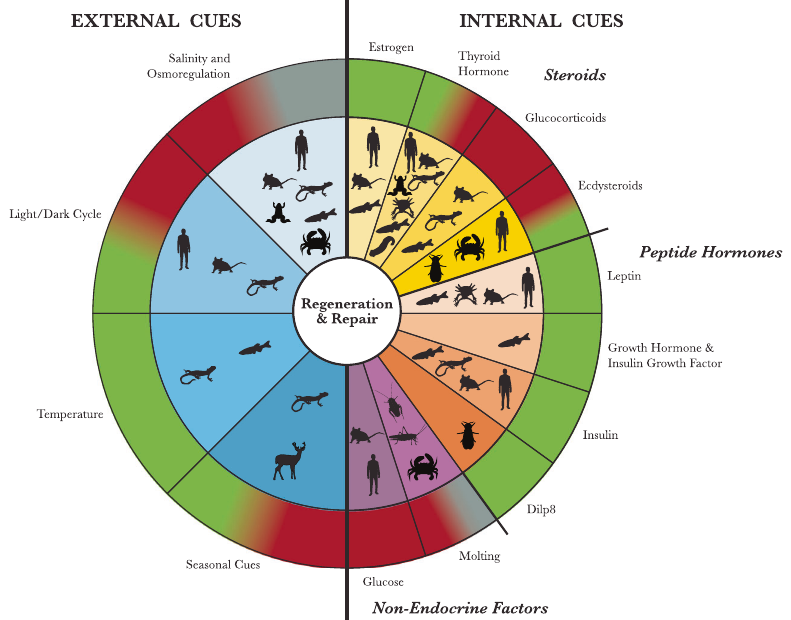
Fig. 1 An overview of internal and external systemic mediators of regeneration and repair. Silhouettes indicate the organisms that will be discussed in the different sections of this review. The outer ring indicates the effect of increased application of each factor on the healing process; green indicates that an increase is bene fi cial for regeneration or repair, red indicates that an increase is detrimental to the healing process, and gray indicates a neutral or insigni fi cant response. Gradients between colors within the same section indicate mixed